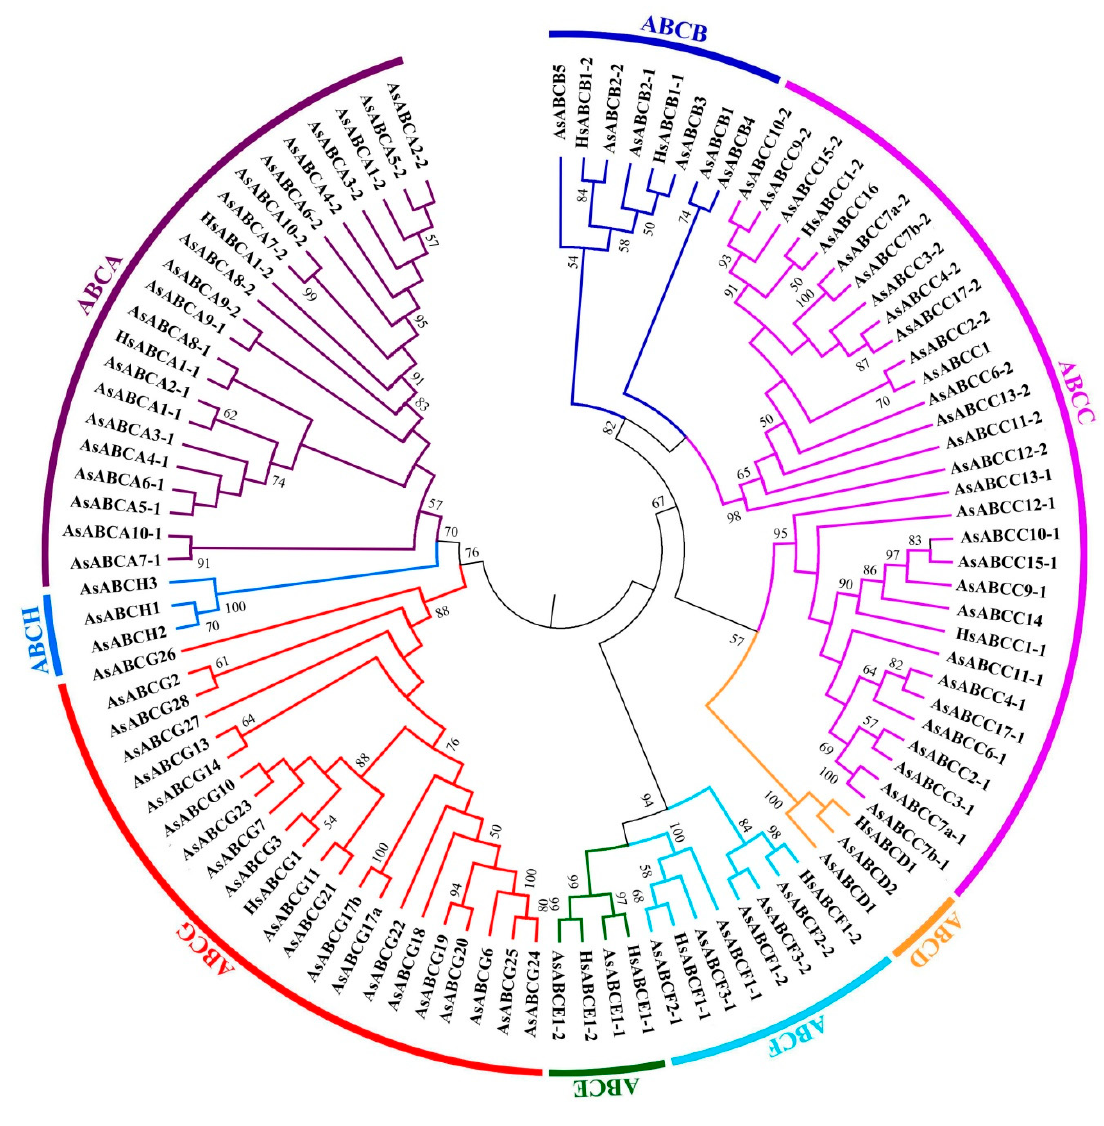
Figure 3. Phylogenetic relationships of the A. sinensis ABC transporter genes. The relationships were inferred based on the amino acid sequences of nucleotide binding domains (NBD) with maximum likelihood method using MEGA5.0, and those genes with two NBDs were treated as two separate gene taxa with each taxon using one different NBD amino acid sequence. The bootstrap values calculated from 1000 replicates were marked on each corresponding node. ABCA, ABCB, ABCC, ABCD, ABCE, ABCF, ABCG, and ABCH represent eight different subfamilies in the ABC transporter family.